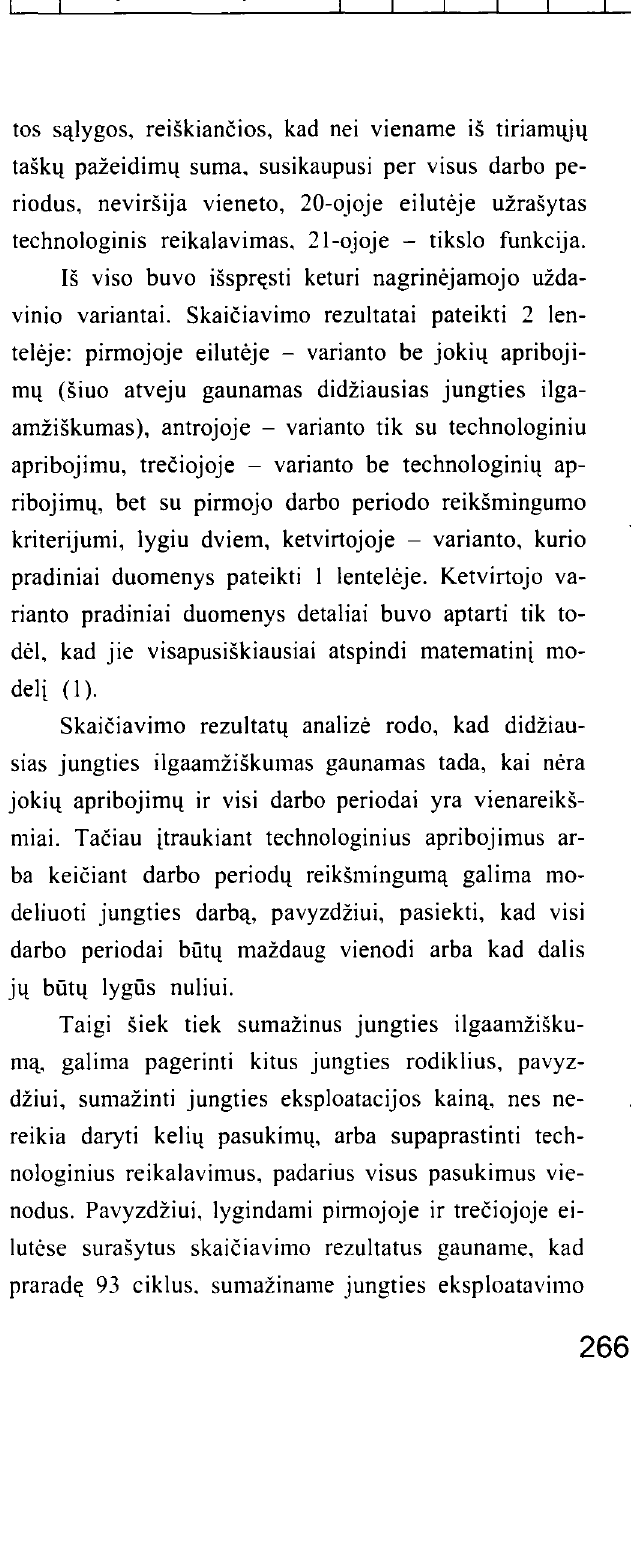
Jungties ilgaamziskumas